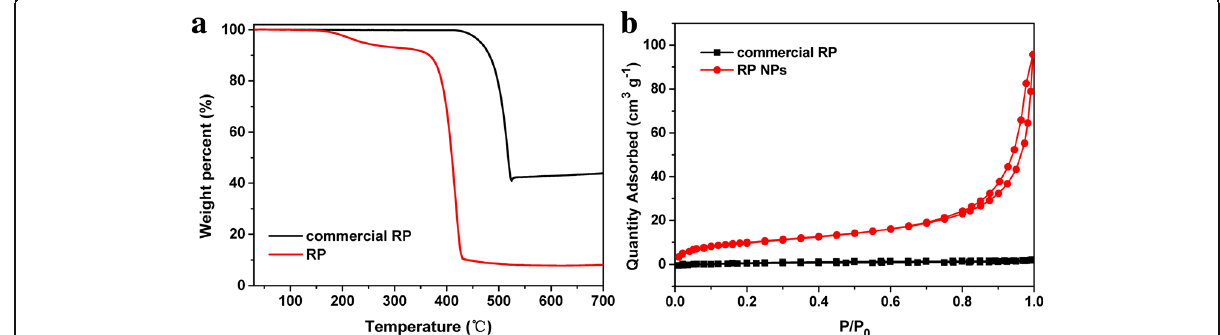
Fig. 3 a TGA of RP NPs and commercial RP. b N 2 adsorption isotherms of RP NPs and commercial